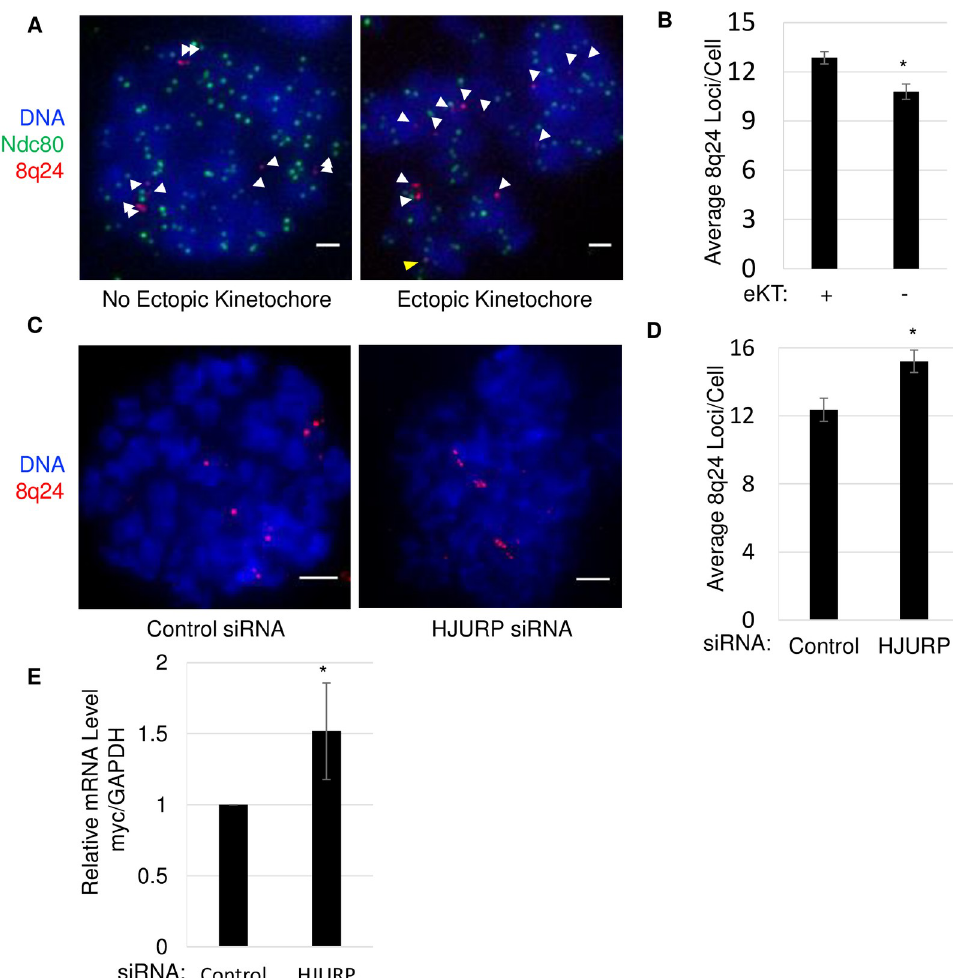
Fig 6. Ectopic kinetochore formation correlates with amplification of the 8q24/MYC locus and increased MYC expression. A.) Images showing IF in mitotic SW480 cells for Ndc80 and FISH for 8q24 locus. Scale bar indicates 1 μ m. White arrows indicate FISH signals. Yellow arrowheads indicate colocalization. B.) Graph quantifying the number of 8q24 loci per cell for both ectopic kinetochore positive and negative cells, indicated by Ndc80 colocalization with at least one 8q24 FISH site. Error indicates SEM from 4 experiments n > 200. ( � indicates P-value < 0.01, Students t-test). C.) Images showing DAPI stained DNA and FISH for the 8q24 locus in either control or HJURP knockdown cells. D.) Graph quantifying the number of 8q24 loci per cell for both control and HJURP knockdown cells. Error indicates SEM from 3 experiments n > 190. ( � indicates P-value < 0.01, Students t-test). E.) Graph showing results of qPCR from mRNA harvested from either control or HJURP knockdown cells. Error measured from 3